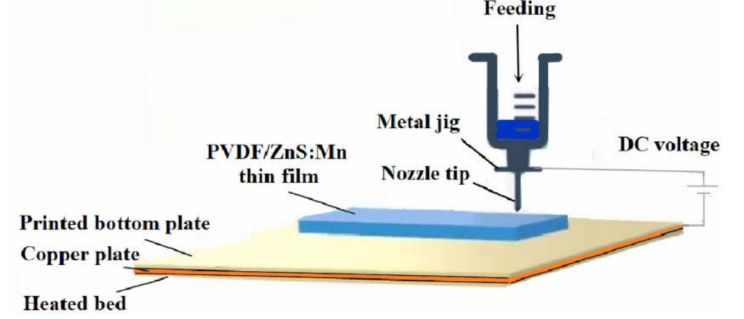
Figure 1. Schematic diagram of 3D-printed PVDF/ZnS:Mn thin film.